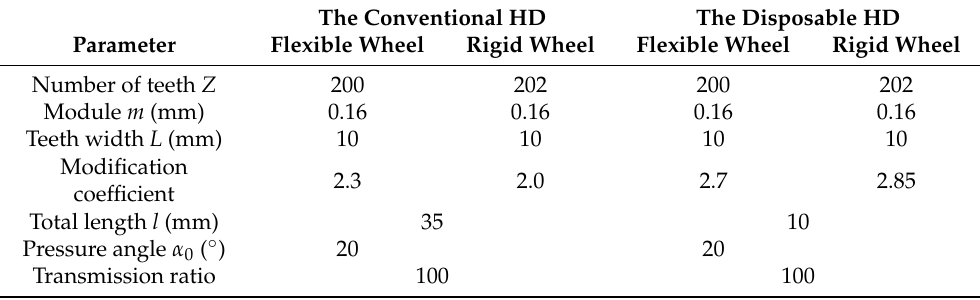
According to the requirements of a cooperative enterprise, the relevant parameters of the disposable HD designed in this study are shown in Table 1. The deformation of the flexible wheel rims under no load after assembly of the conventional HD and the disposable HD are shown in Figure 4. It can be seen that due to the same values of ω ∗ and m, the 0 · m ) of the two flexible wheels are the same after maximum radial deformation ( ω 0 = ω ∗ 0 assembly. Table 1. Parameters of the HD. The Conventional HD The Disposable Table 1. Parameters of the HD.